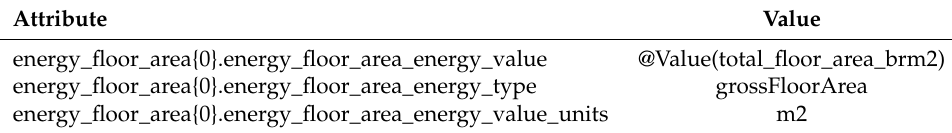
Table 1. Definition of ab Energy ADE floorArea property in the FME attribute manager.